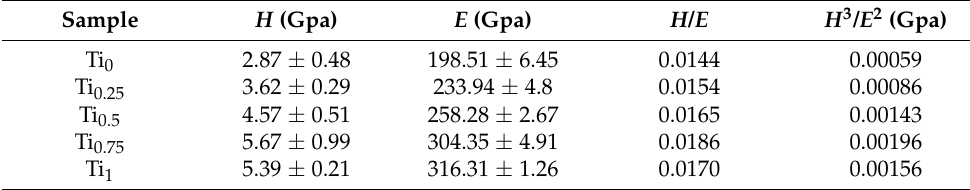
Table 3. Nanoindentation characteristics of CoCrFeMnNiTi x